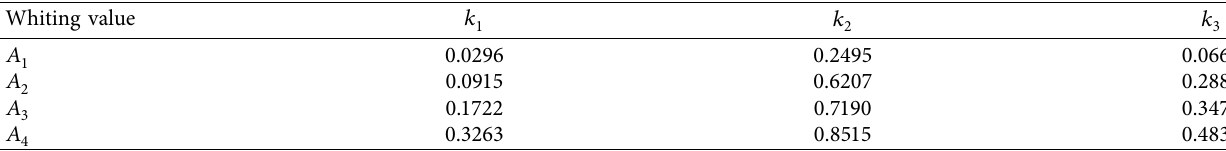
Figure 10: Schematic diagram of whitenization weight function. Table 2: Whiting values of each evaluation index.